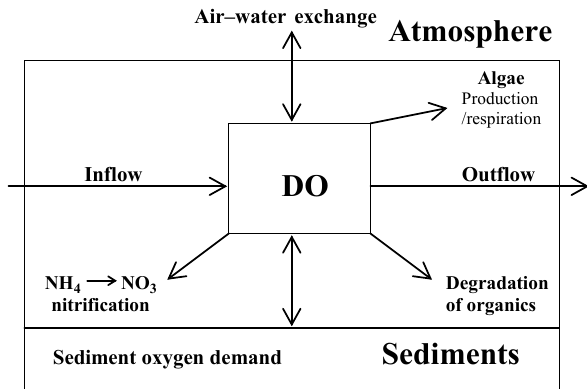
Figure 1. Schematic of dissolved oxygen dynamics in